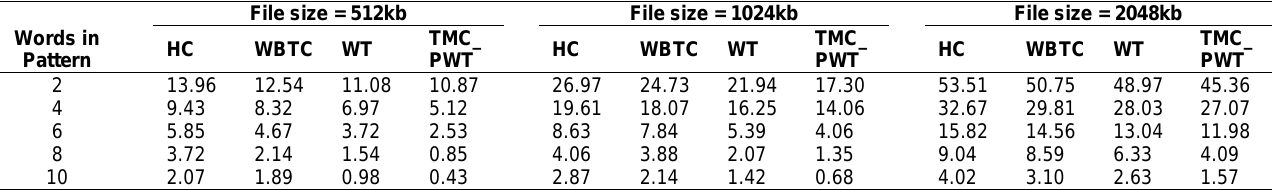
Table 17. Running times of algorithms (for fixed alphabet size = 128)